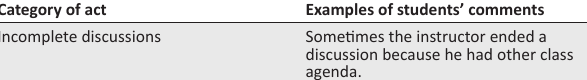
TABLE 10 : Pedagogic acts discouraging dialogue. Category of act Examples of students’ comments